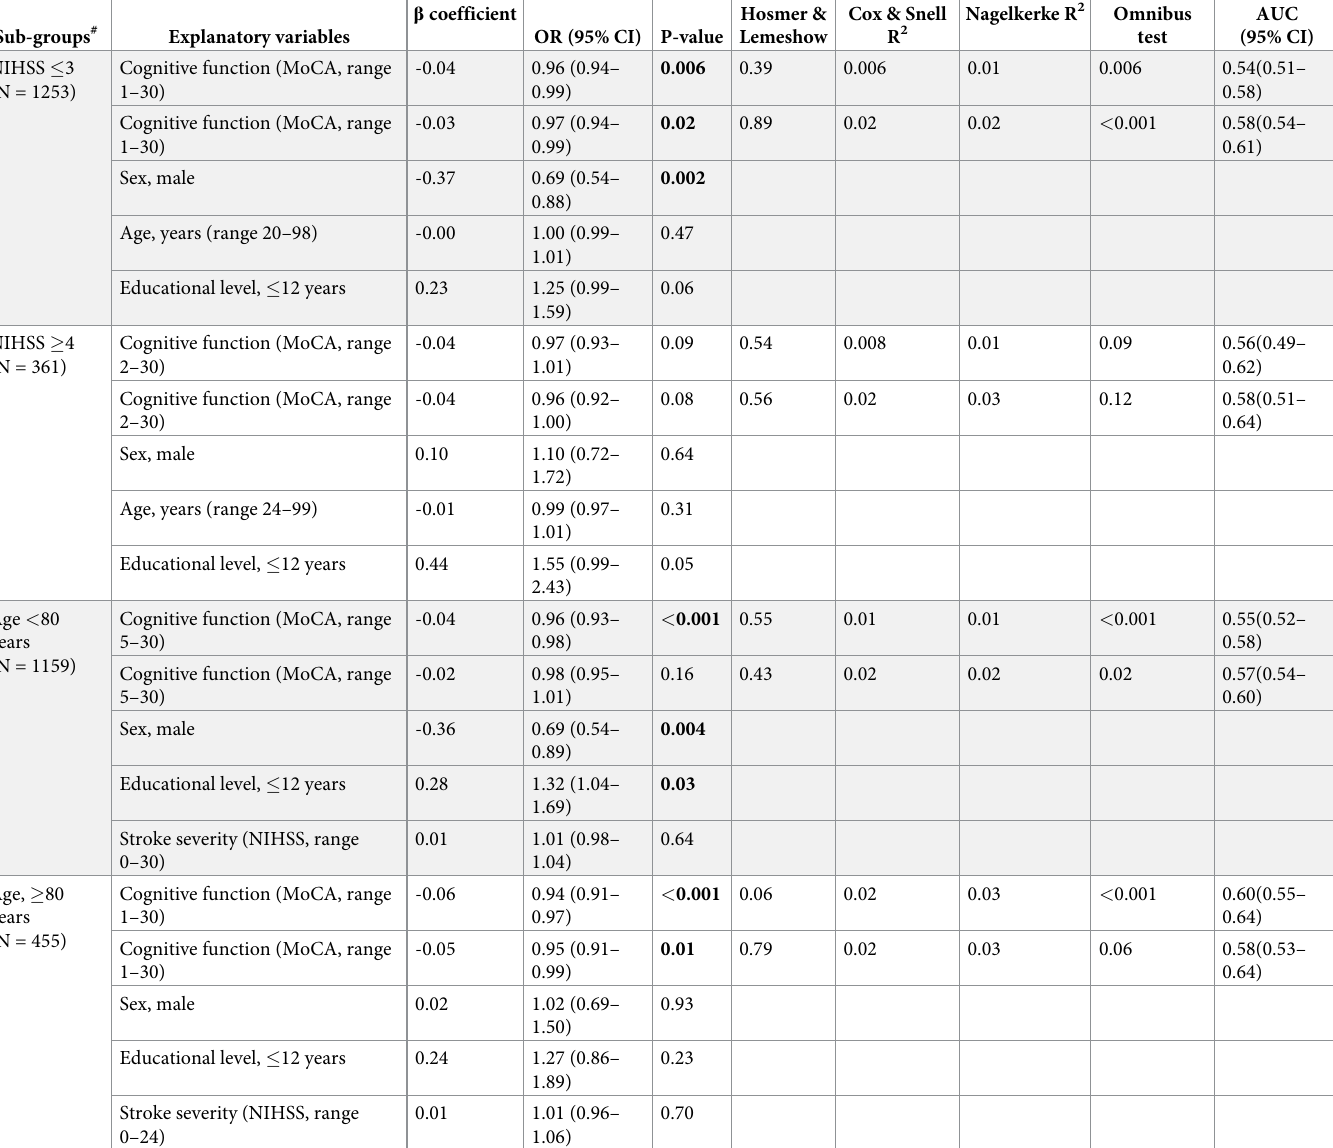
Table 4. The results of binary logistic regression analyses showing the explanatory value of cognitive function screened early after stroke for subjective cognitive compliant after 3 months. Sub-groups